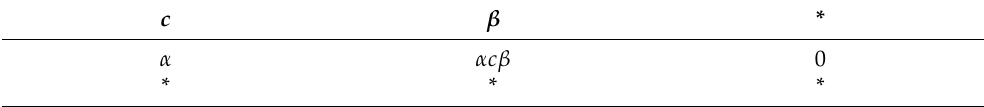
Table 1. Definability of connectives